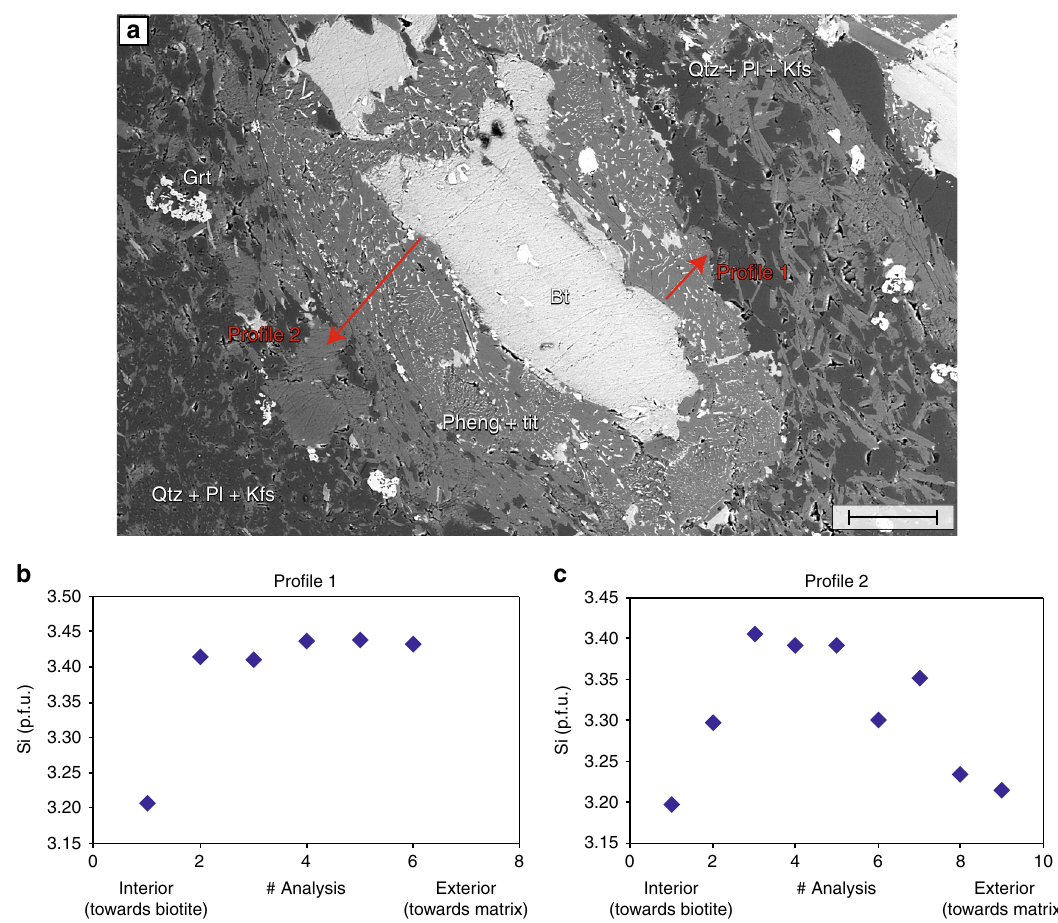
Fig. 4 Microphotograph and compositional pro fi les of phengite rim in undeformed metagranite. a Backscattered electron image showing phengite rim around biotite. Scale bar, 100 µ m. b , c Spatial variation of silica (Si) per formula unit (p.f.u.) in phengite for two pro fi les from a metagranite sample indicated in a . Pro fi les were measured in the reaction rims around biotite, from interior towards the matrix. The values of silica show a bell shape. The variations are interpreted to document prograde replacement of biotite by phengite, from the rim towards the centre, with subsequent pressure decrease during the retrograde phase, close to the biotite. Error bars on the silica are smaller than the symbol